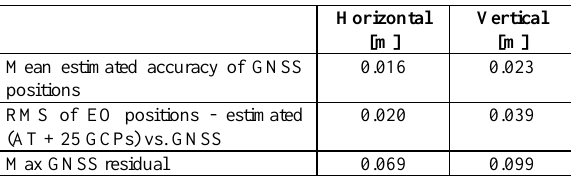
Table 3. Summary of the quality of the GNSS data